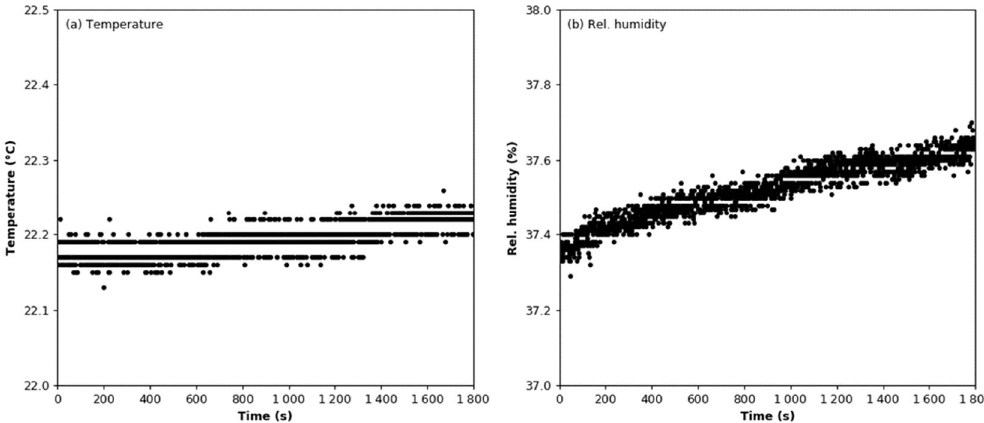
Figure 4. Environmental conditions during the stability test: ( a ) Air temperature; ( b ) relative humidity.